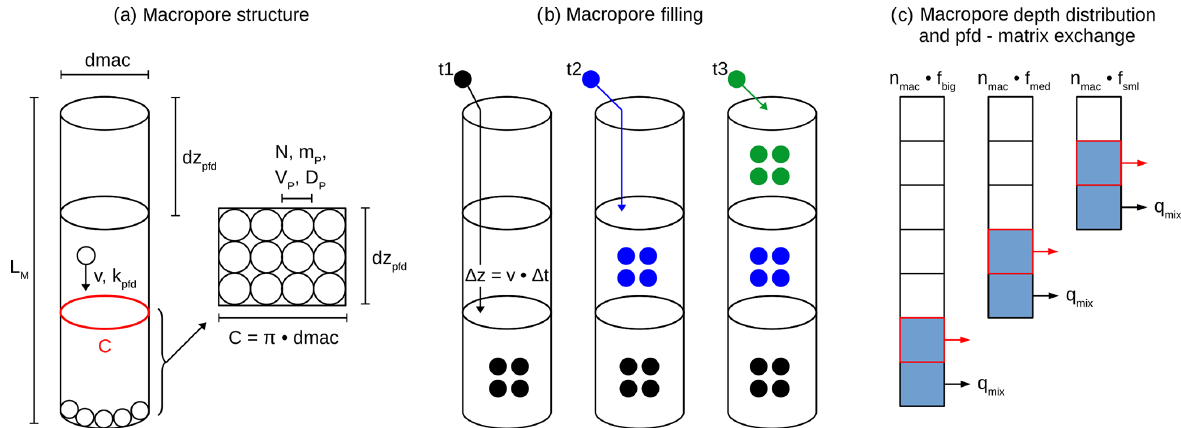
Figure 2. Conceptual visualization of (a) the macropore structure and cubic packing of particles in the rectangle of a cut-open and laid-flat grid element cylinder (cf. Sect. 2.3.1), (b) the macropore filling with gradual saturation of grid elements, exemplarily shown for three points in time ( t 1– t 3) whereby at each time new particles (differently coloured related to the current time) infiltrate the macropore and travel into the deepest unsaturated grid element (cf. Sect. 2.3.3) and (c) the macropore depth distribution and diffusive mixing from macropores into a matrix (cf. Sect.